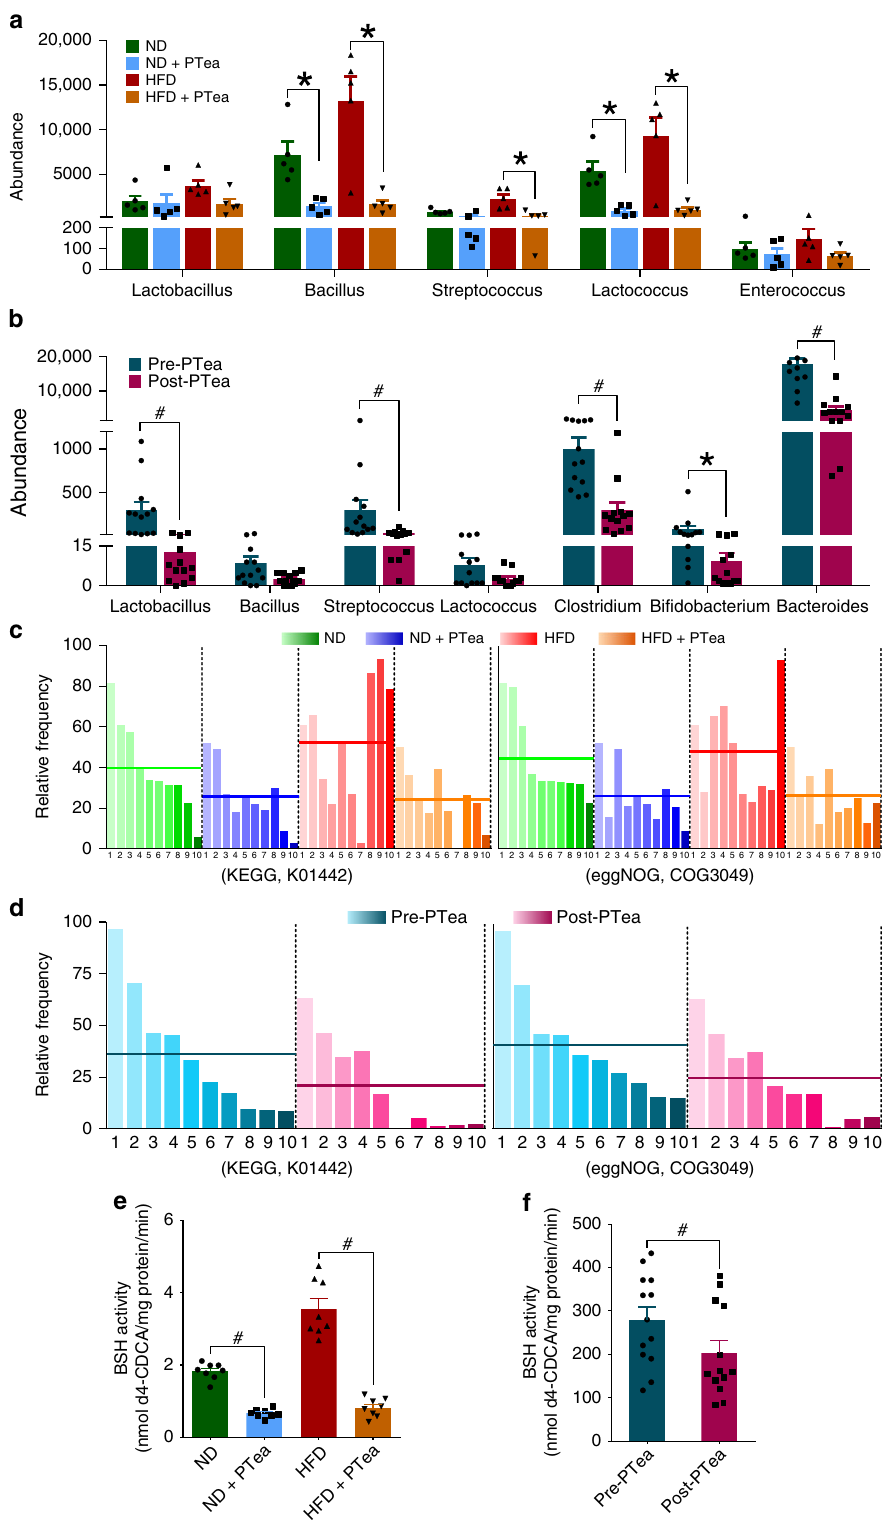
Fig. 3 Pu-erh tea reduced the abundance of BSH microbes and BSH activity. a Abundance of BSH enriched microbes in ileum of mice undergoing Pu-erh tea consumption. n = 5 individuals/group. b Abundance of BSH enriched microbes in feces of humans consuming Pu-erh tea. n = 13 individuals/group. c The microbial BSH enzyme activity in the ileal contents of mice treated with Pu-erh tea. d The microbial BSH activity in human feces from subjects on Pu-erh tea consumption. The functional pro fi les were identi fi ed by metagenomic analysis utilizing both KEGG and eggNOG databases. BSH related proteins ranked in the top ten are shown and the mean abundances are illustrated as the horizontal line in each group. e Ileal BSH activity in mice on Pu-erh tea consumption. n = 8 individuals/group. f Fecal BSH activity inhuman subjects on Pu-erh tea consumption. n = 13 individuals/group. Data were expressed as mean±SEM. Differences in the data for mice and human subjects were assessed by the Mann – Whitney U test and Wilcoxon rank-sum test, respectively, * p <0.05, # p